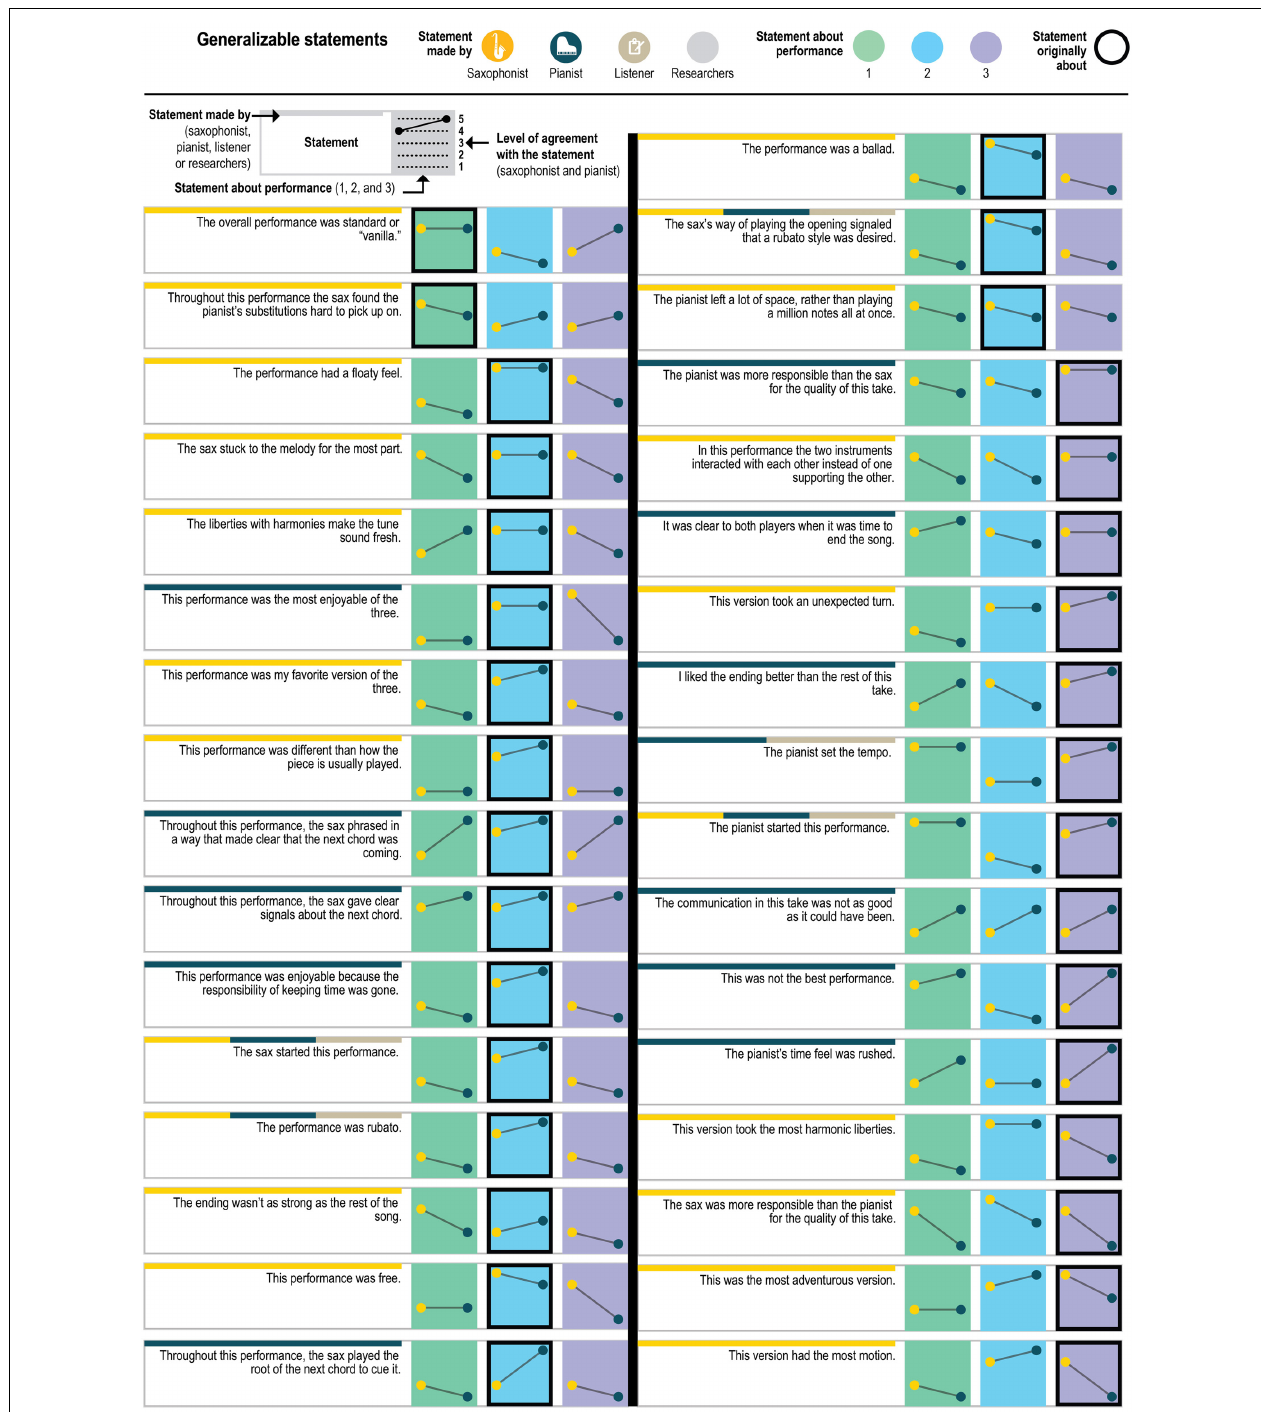
FIGURE 6 | Players’ ratings of the generalizable statements for all three recordings.